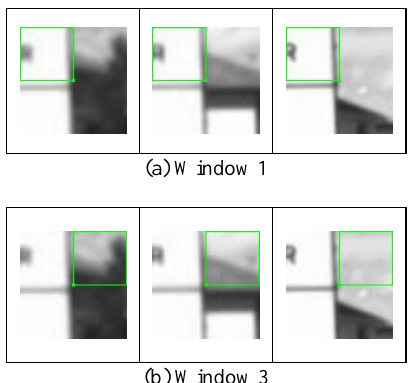
Figure 8. The influence of background with window 1 is less than window 3.